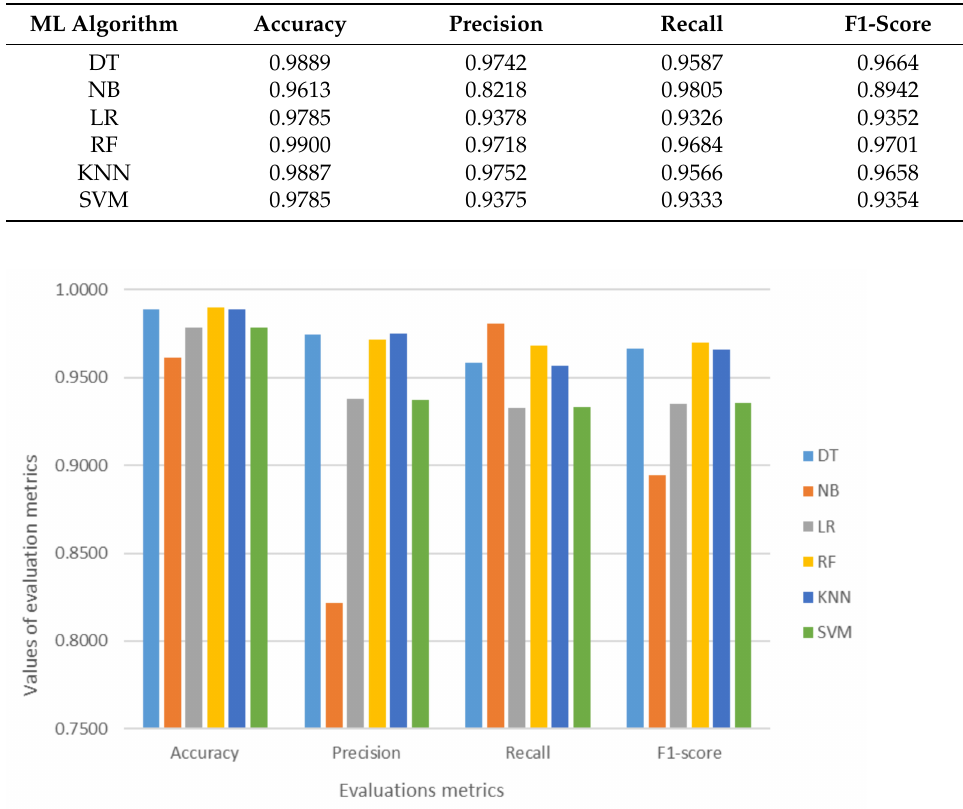
Figure 7. Evaluation metrics for binary classification for the “all_powertrace”